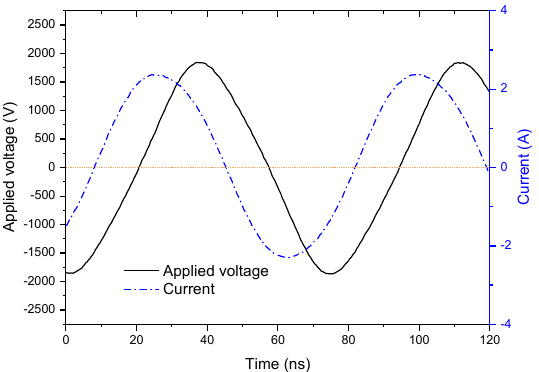
Figure 10. Photos of filamentous discharge at 0T, 1/4T, 1/2T and 3/4T of one current cycle (73.7 ns), P = 420 W, N 2 = 150 mL/min, gas mixture = 2 L/min. Exposure time: 2 ns. In addition, it can be observed from the photos in Figures 4 and 5 that, except for the filaments in Figure 5a, which are in a state of random migration, the whole plasma slowly moves down with the flow of the discharge gas, and the positions of the filaments are relatively fixed. On the other hand, it can be seen from the waveforms shown in Figure 11 that the current waveform of RF-DBD is smooth, which is different from the current waveform of middle-frequency DBD [23]. Therefore, it can be concluded that the filaments are not extinguished during one period.